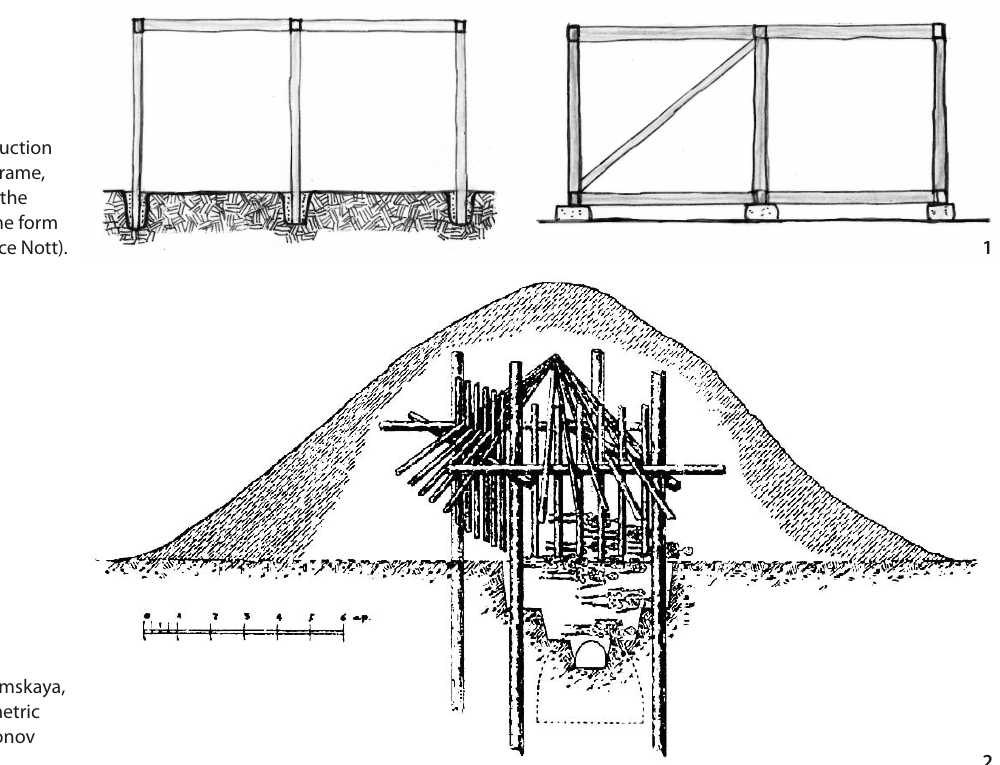
Figure 2 Barrow I, Kostromskaya, early 6 th century BC, isometric diagram (Source: Artomonov 1969, drawing V).